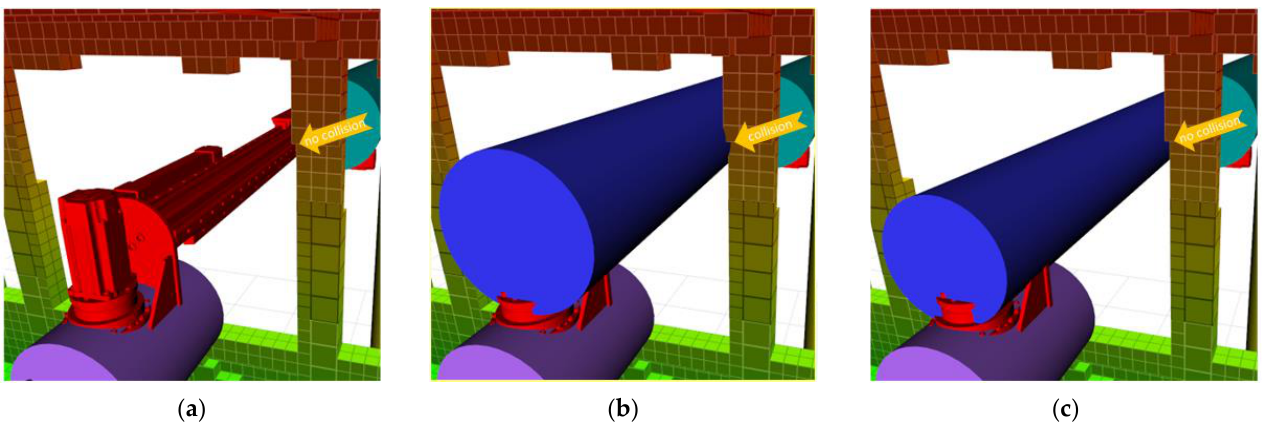
Figure 18. ( a ) Visualization of the 3rd robot link. ( b ) Representation of cylinder C 3 with radius 0.1425. The radius causes a collision, unlike the real system. ( c ) Representation of cylinder C 3 with radius 0.124. It provides the closest and most consistent motion to the real system.